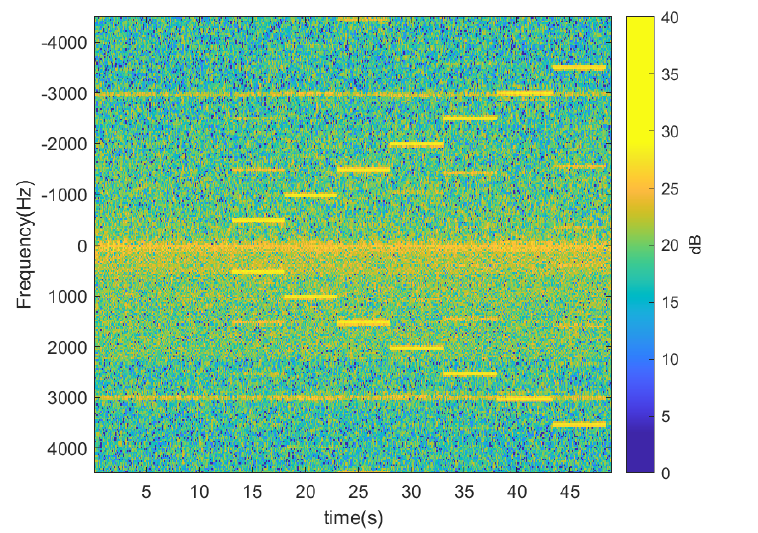
Figure 14. Spectrogram for different modulation frequencies with the immobilized tag located in front of the radar at 2 m.